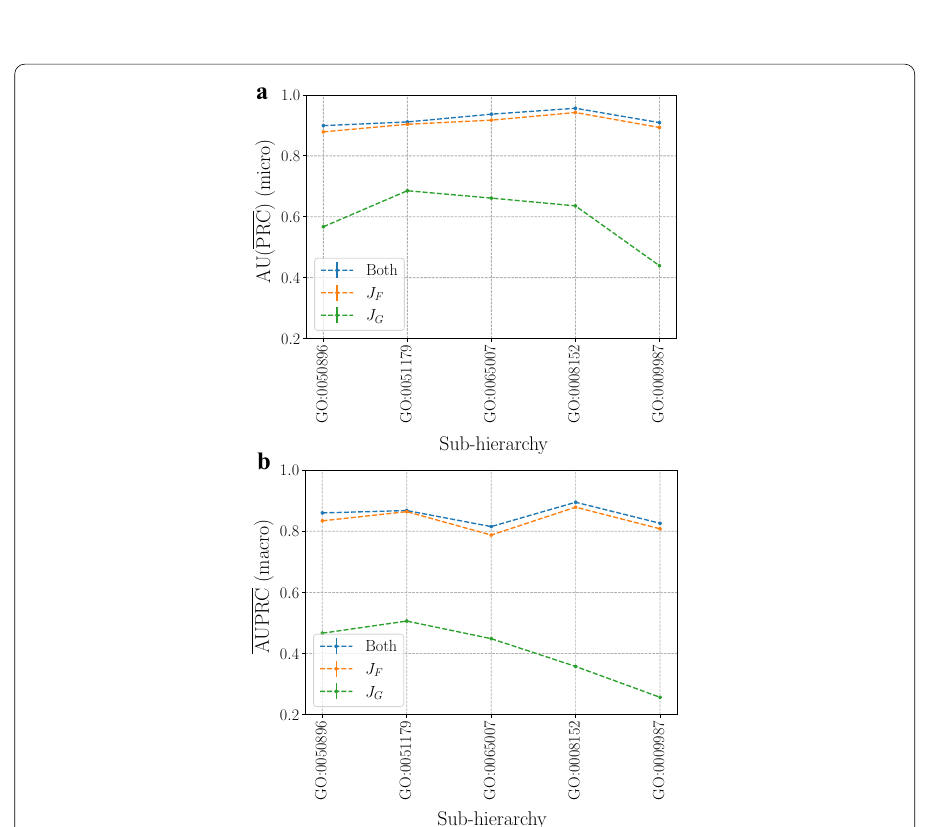
Fig. 10 Prediction performance of the global method trained using the features J G and J F independently, and the proposed approach (i.e., their combination) measured with AU( PRC ) and AUPRC . The performance is measured independently per